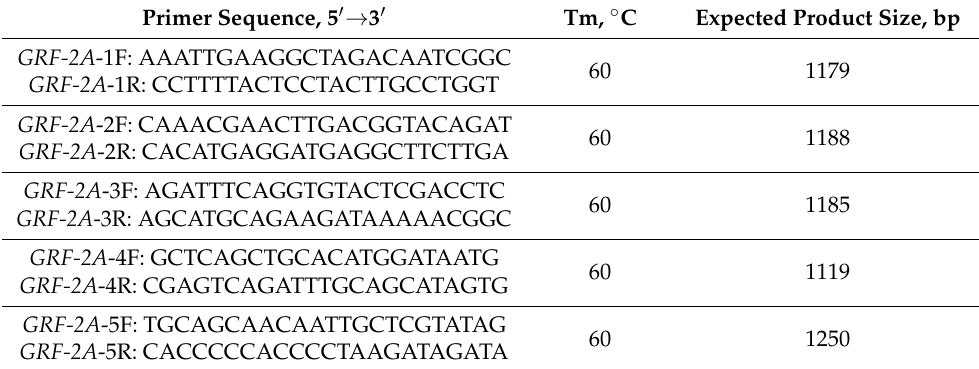
Table 2. Primers used for PCR-amplification of the TaGRF3-2A